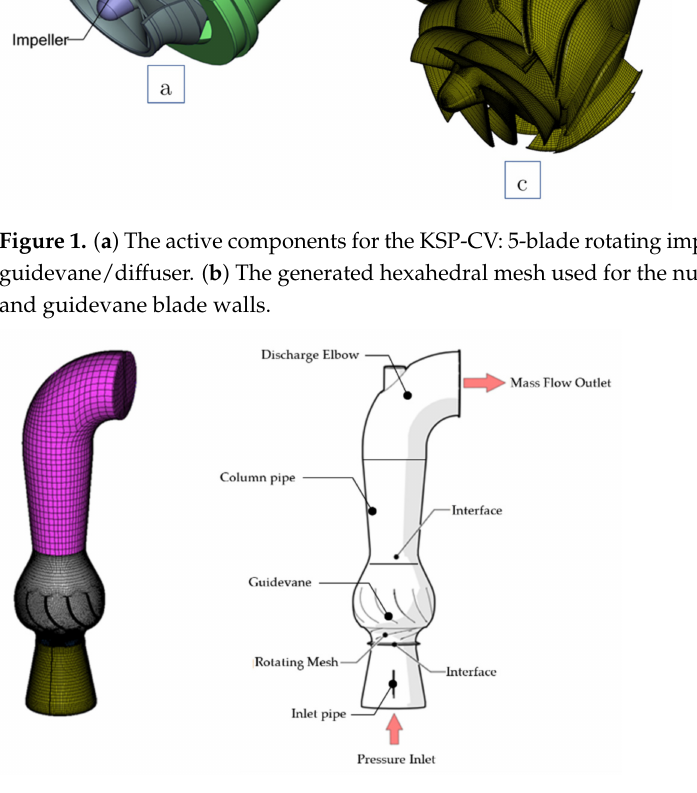
Figure 2. A schematic of the whole computational domain ( right ) and the mesh for the whole assembly ( left